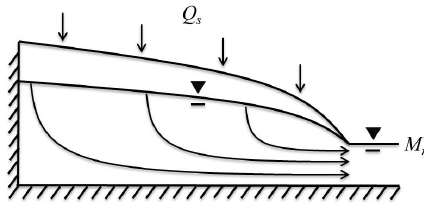
Figure 3. Schematic of a simple profile with Dirichlet boundary conditions on the right and left (M r ,M l ) a constant source ( Q s ), and steady-state, variably saturated groundwater flow. In this symmetric case, there exists a water divide in the center of the domain. In the theory, the vertical and horizontal extents of the cross section are assumed to be